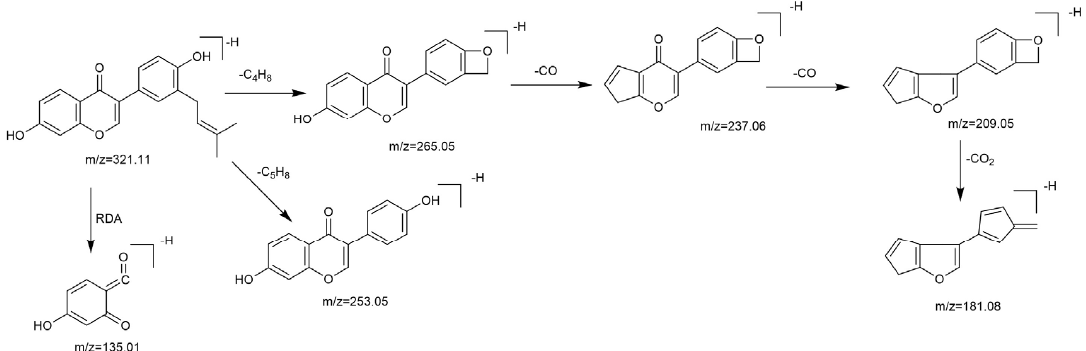
Figure 3. The proposed fragmentation pathways for neobavaisoflavone in the negative ion mode.